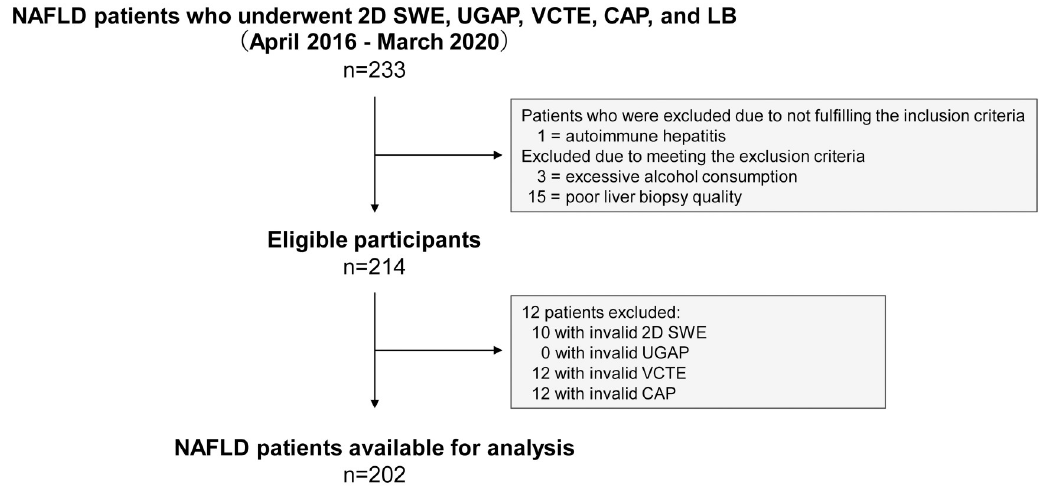
Fig 1. Flow diagram of the study population. 2D SWE, 2D shear wave elastography; UGAP, ultrasound-guided attenuation parameter; VCTE, vibration-controlled transient elastography; CAP, controlled attenuation parameter; LB, liver biopsy. AUROC curve, potential cutoff, sensitivity, specificity, PPV, NPV, LR+, and LR − values for each liver fibrosis stage (Table 2). AUCs were higher for 2D SWE than for VCTE in all stages, but this was not statistically significant.